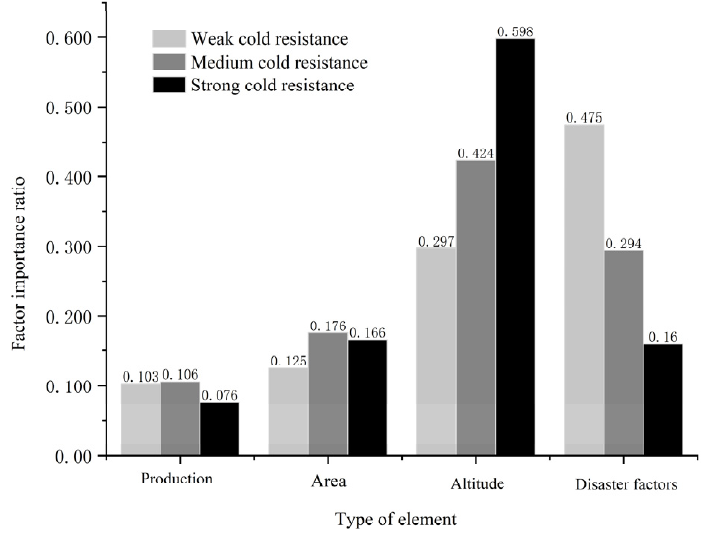
Figure 6. Element Importance Distribution.